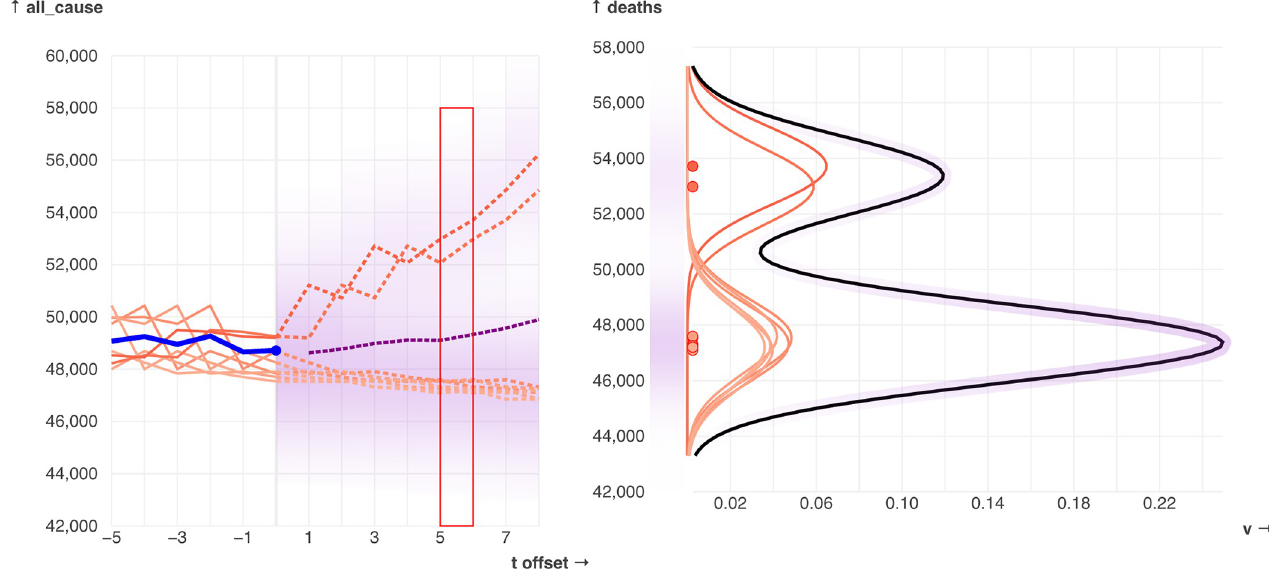
Fig 3. An example of how the weighted kernel density estimation works, and how the resulting values are mapped onto colors for the shaded forecasting area. The example is from t = 82 and tp = 8 on the default mortality data, with the relative kernel width parameter, kernel_width set to 1.0. A gaussian kernel is placed at each neighbor’s value; higher weighted neighbors (represented with a darker color) correspond to taller and thinner kernels. The sum of the kernels forms the forecast distribution (black line) which is then linearly mapped onto an opacity value used to draw the color gradient.